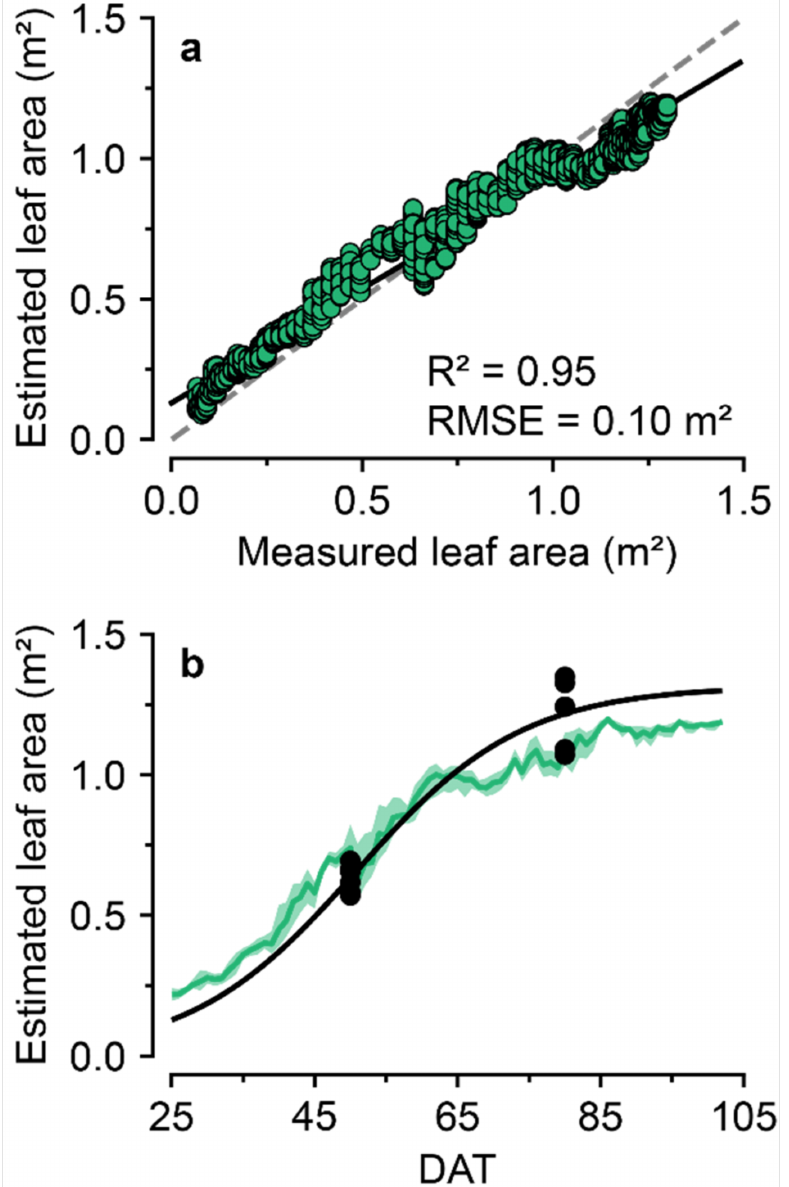
Figure 8. ( a ) Test accuracy of the trained 2D ConvNet for estimating the leaf areas (from 25 August 2020 to 24 January 2021; 2020W). ( b ) Comparison of the estimation based on days after transplanting (DAT). Daily maximum and minimum are depicted by a shaded